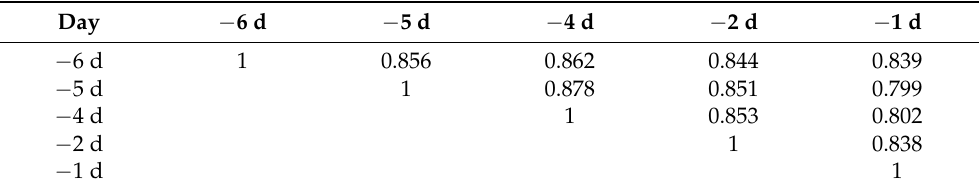
Table 3. The Euclidean Distance (ED) score for the diurnal pattern of hens using the nest box for each day from − 6 d to − 1